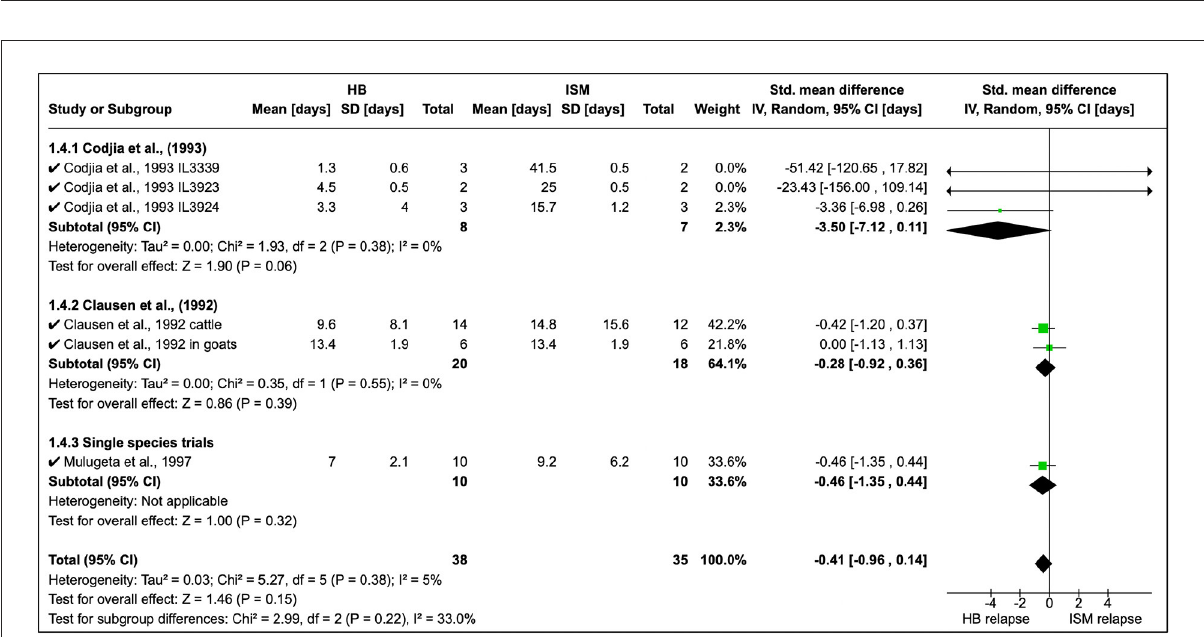
FIGURE5 Mean relapse time in preclinical trials with homidium bromide and isometamidium